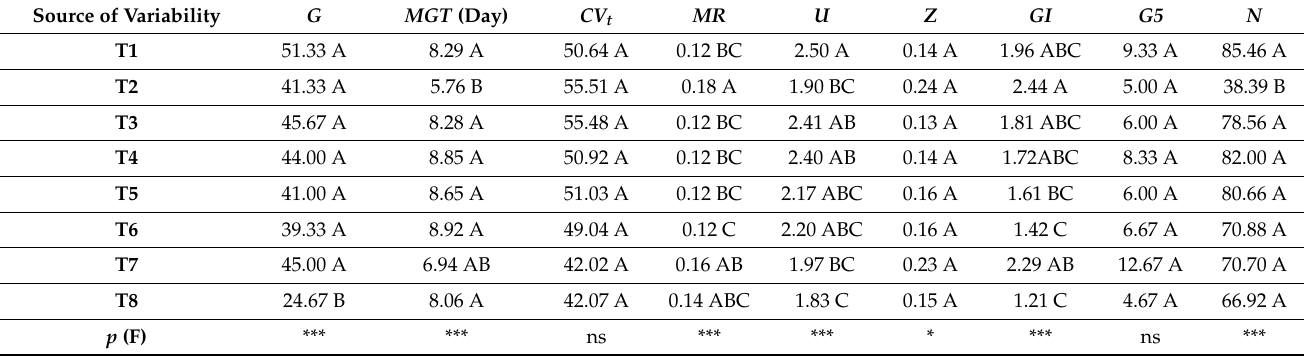
Table 4. Differences between treatments for the germination parameters in the first phase of the experiment of the seed germination of three winter savory natural populations under drought